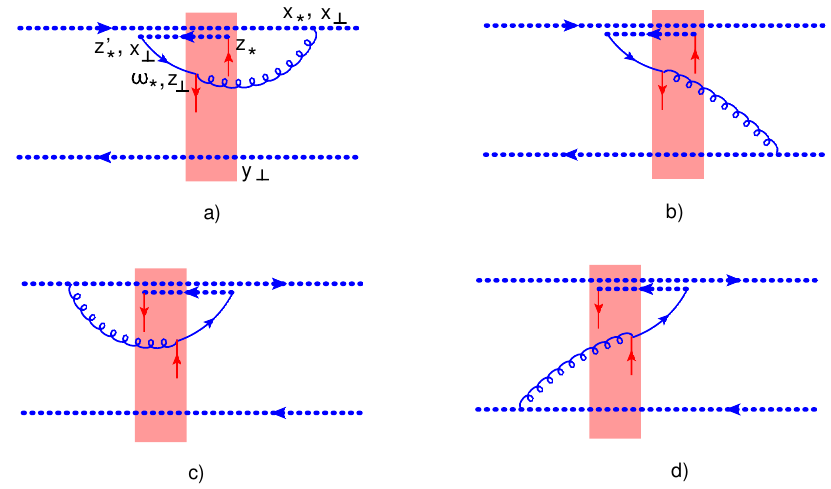
ˆ Q 1 ( x ⊥ ) and 5 ( x ⊥ )